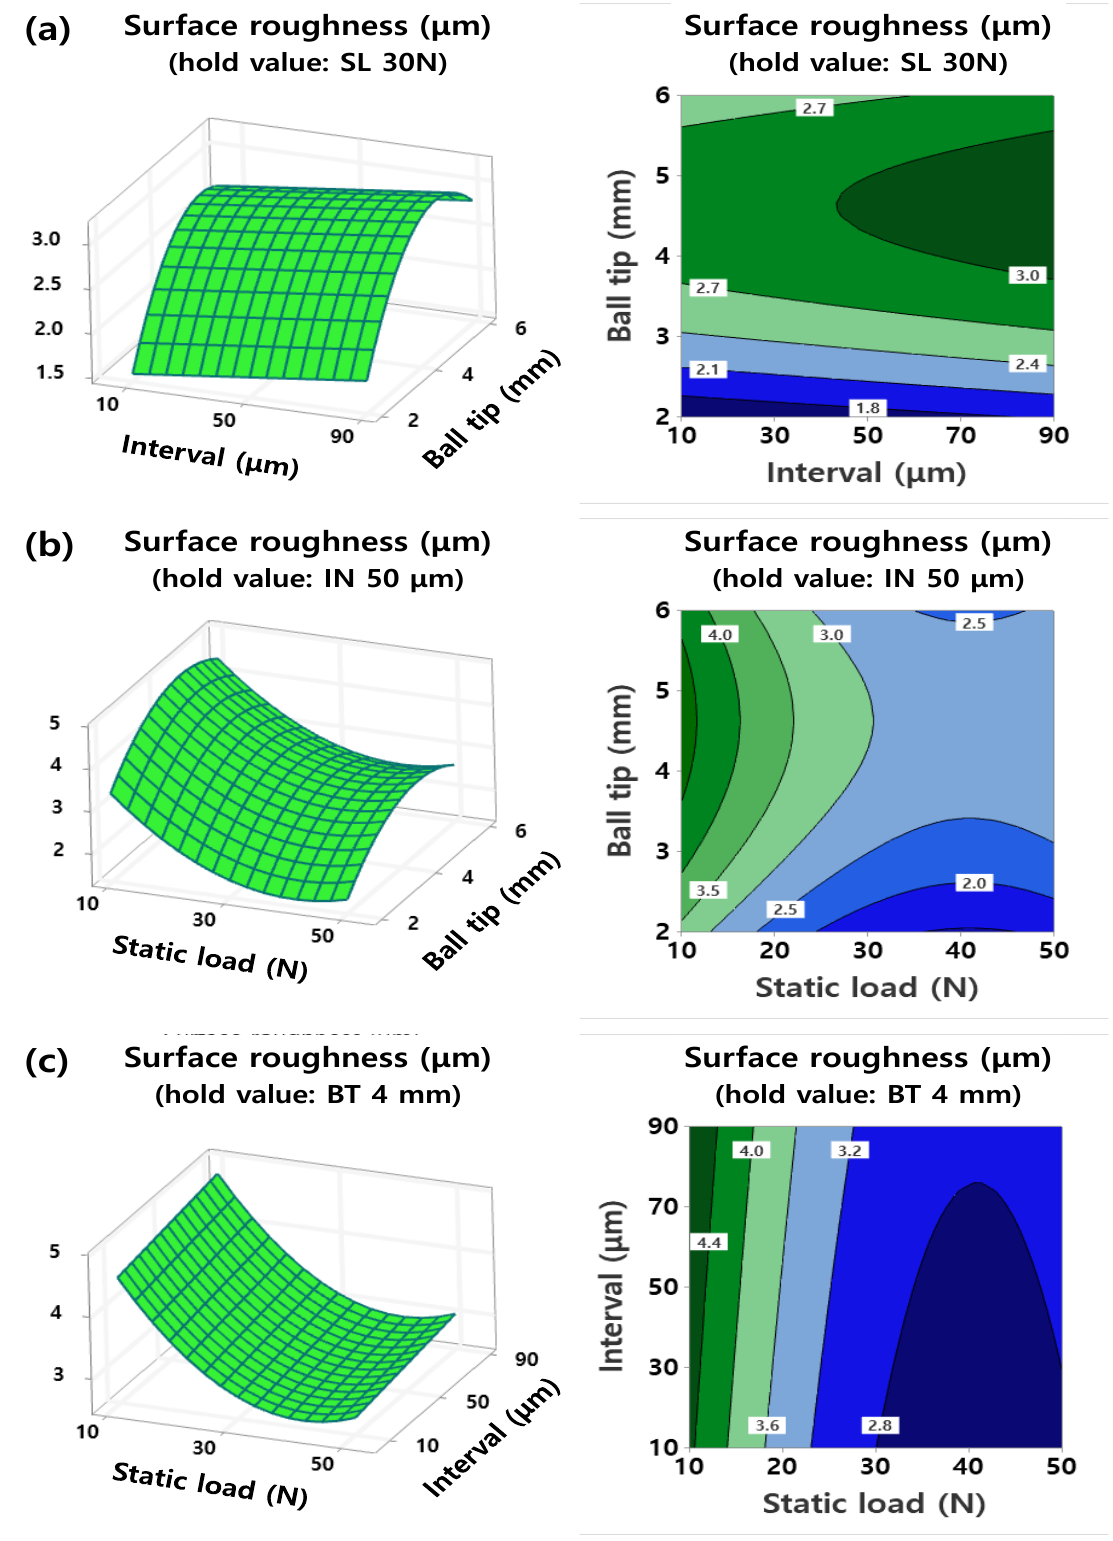
Figure 7. RSM results for roughness between ( a ) inter-pass interval and ball tip diameter, ( b ) load and ball tip diameter, and ( c ) load and inter-pass interval.